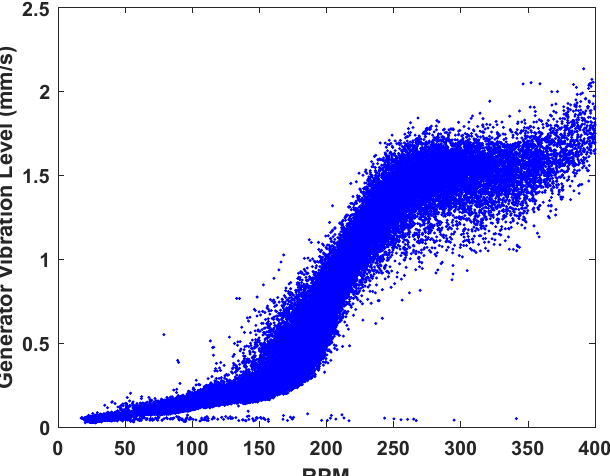
Figure 8. RMS values of the axial vibrations of the generator for each 1-minute data set.